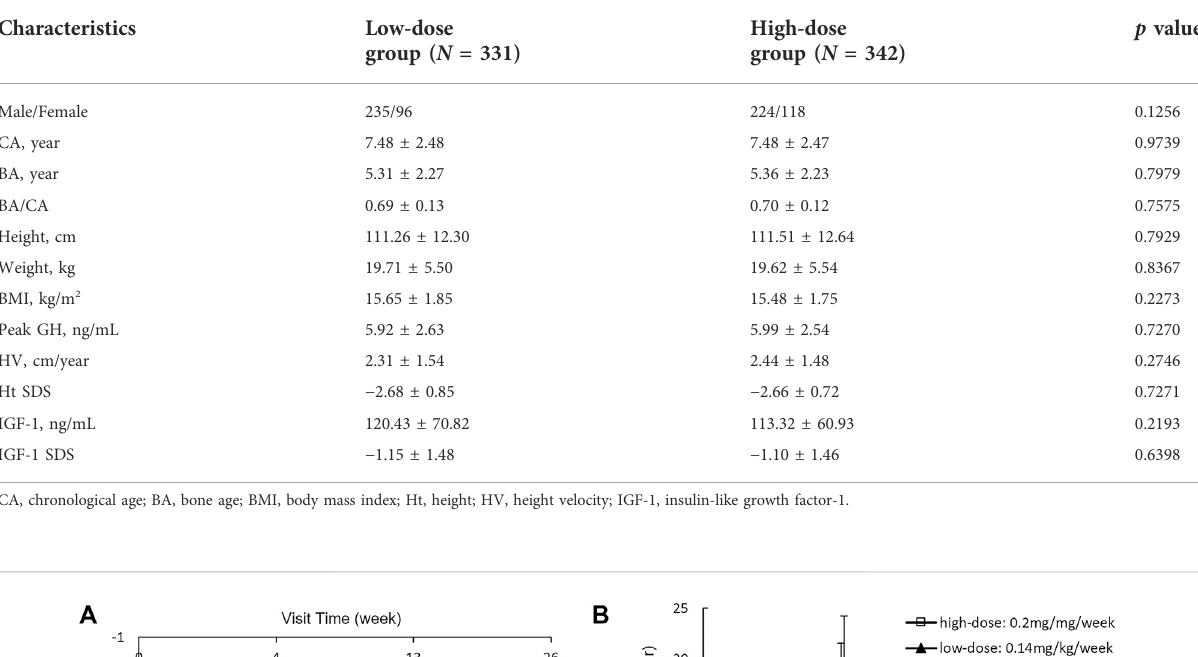
TABLE 1 Demographic and clinical characteristics at baseline (mITT).